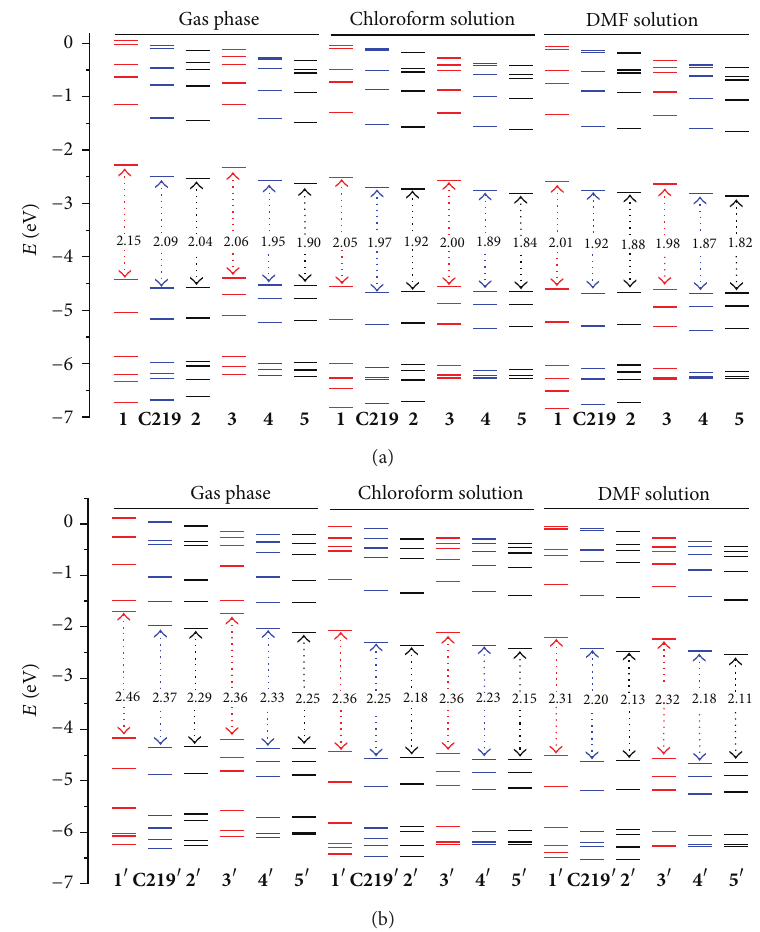
Figure 3: Energy levels and HOMO-LUMO gaps of the tpa-based